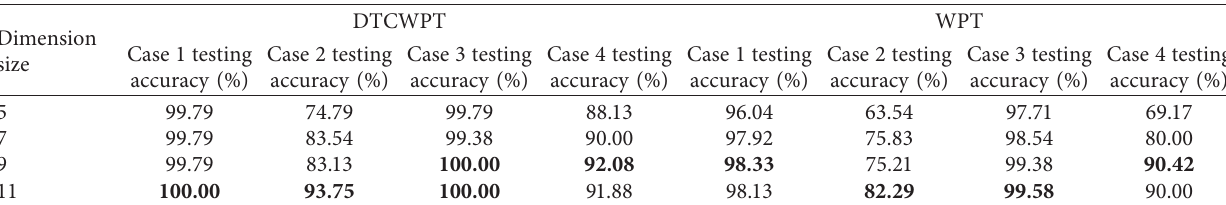
Table 10: Bearing fault diagnosis results obtained by OFS-LMMC-SVM.